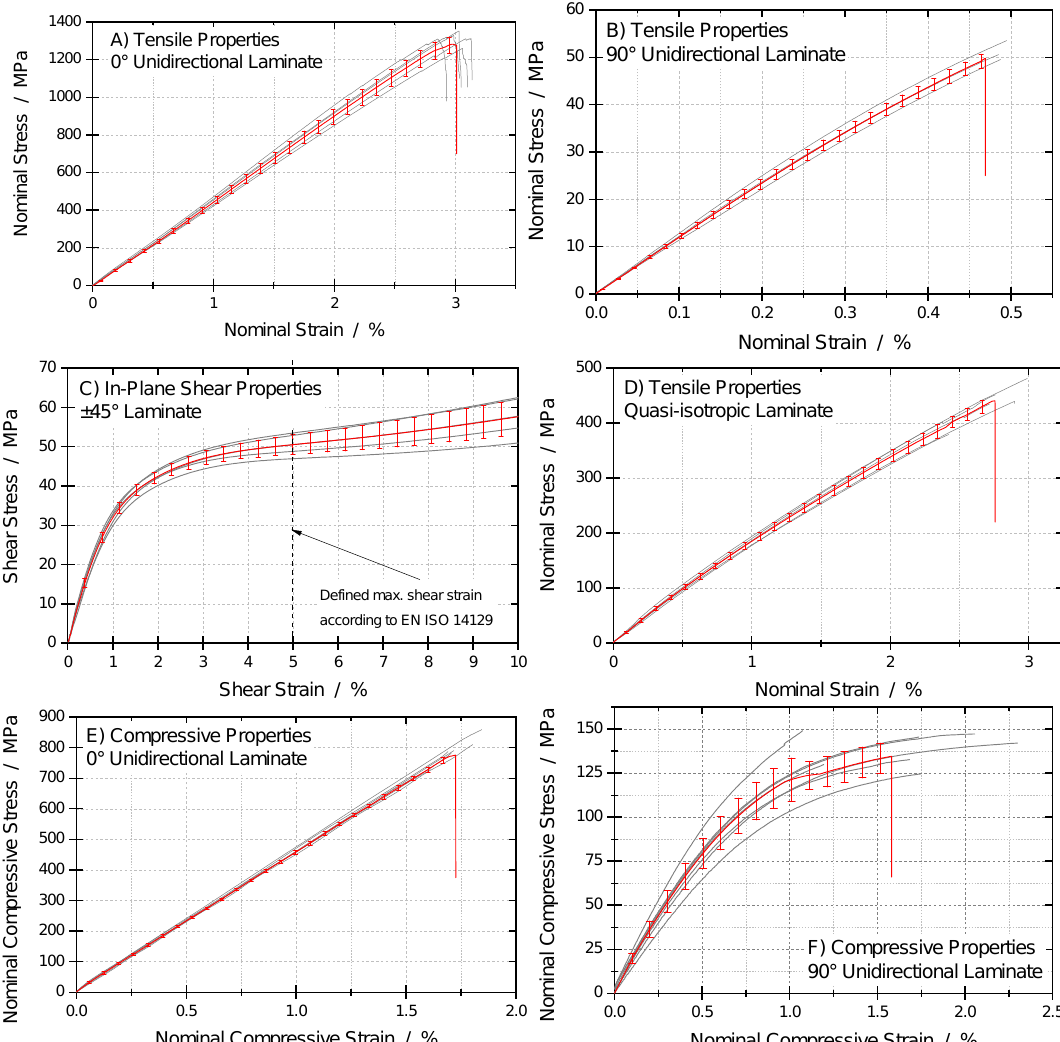
Figure 4. Tensile and compressive stress/strain behaviour of the unidirectional basalt/epoxy polymer. The red curve represents the average of the individual tests (grey lines). Vertical error bars represent the standard deviation of the average